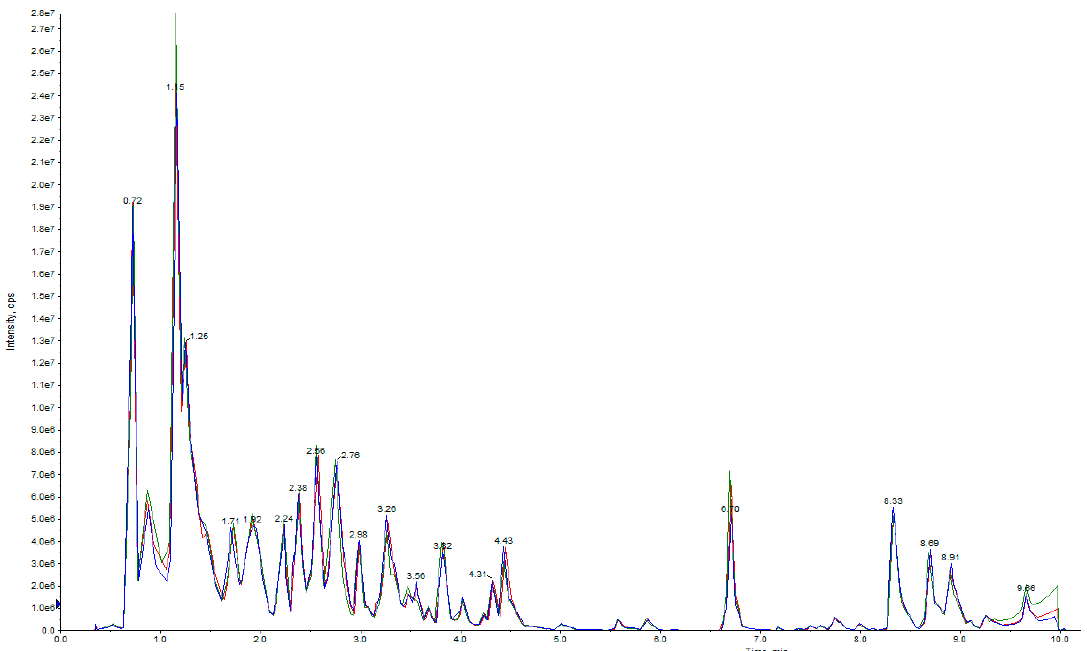
Figure 2. Overlapping analysis of the total ion current (TIC) in different quality control (QC) samples. The abscissa represents the retention time (min) of metabolite detection, and the ordinate represents the intensity of the ion current (cps: count per second).